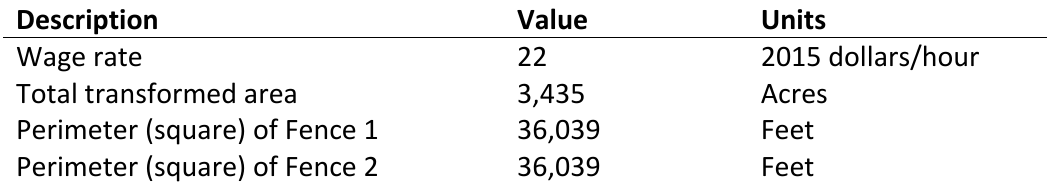
Table A1.5. Parameter descriptions and values for native forest restoration scenario